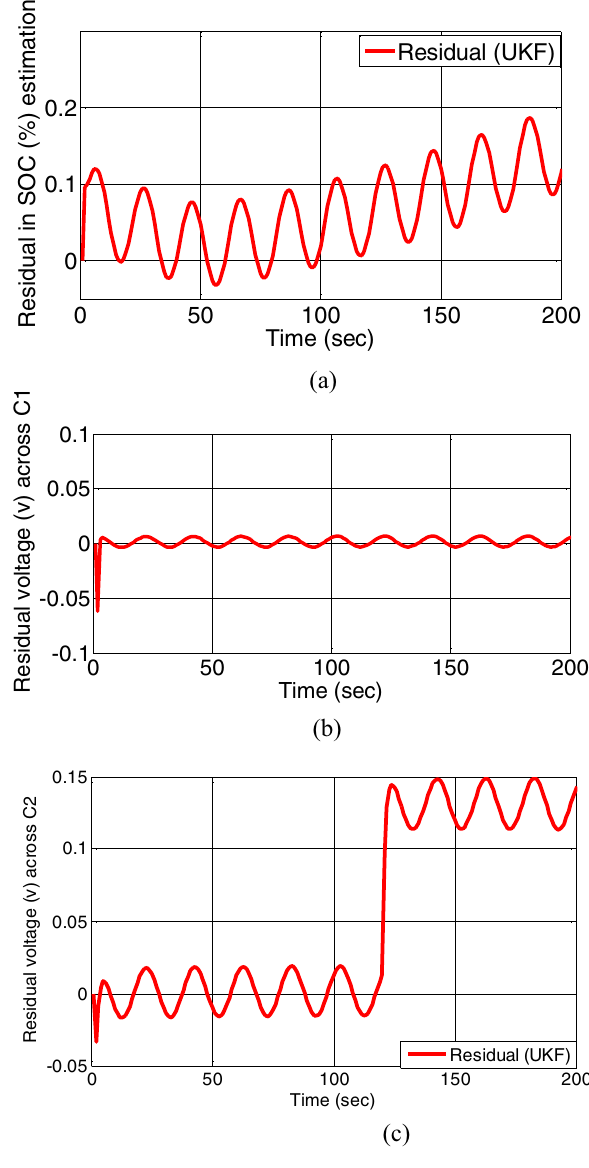
Figure 12. ( a ) Residual estimation of SOC, ( b ) residual estimation of voltage across charge transfer capacitance, ( c ) residual estimation of voltage across double layer capacitance by